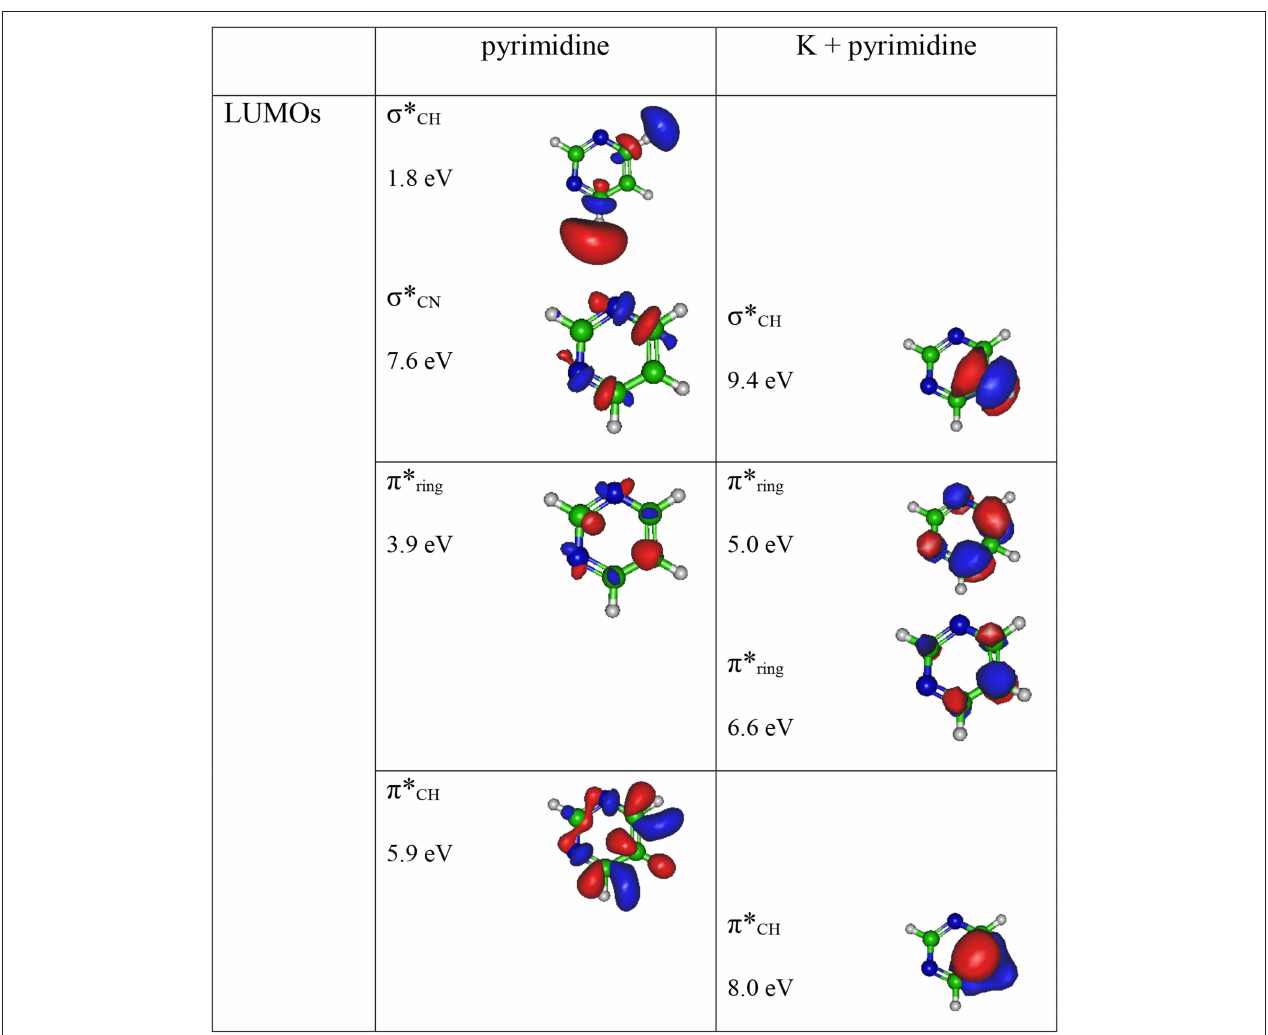
FIGURE 2 | Calculated lowest unoccupied molecular orbitals (LUMOs) for pyrimidine (Pyr) and pyrimidine (Pyr) in the presence of a potassium perpendicularly to the pyrimidine ring ( Figure 1 ). Energies in eV.